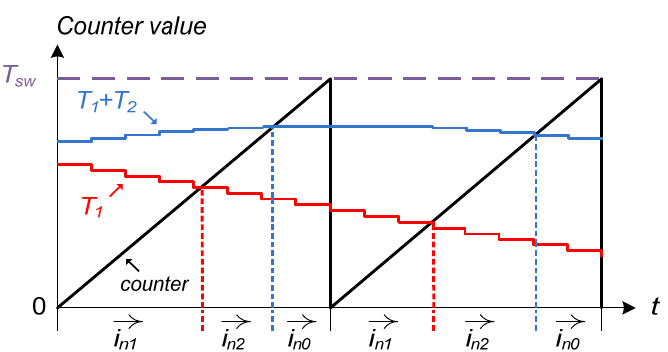
Figure 14. Vector selection in MS-SVM [24].